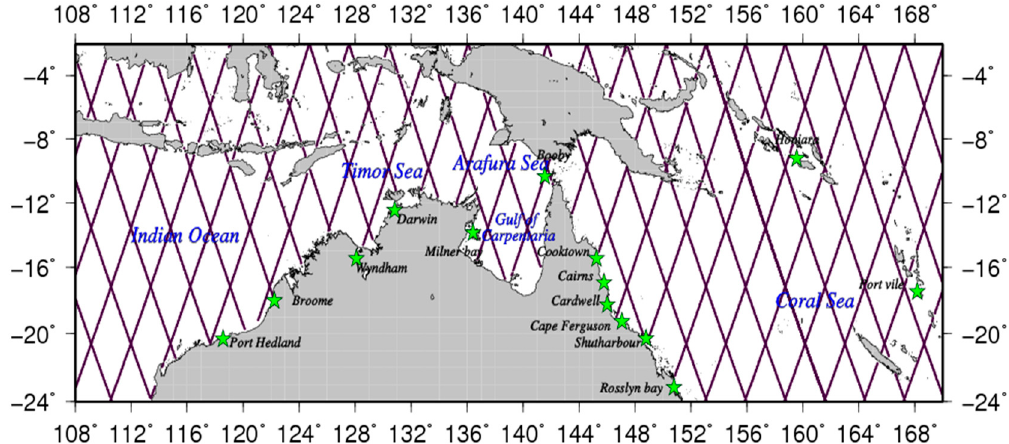
Figure 2. Locations of tide gauges (green stars) and distribution of satellite altimeter ground tracks between 1993 and 2013 used for this study.